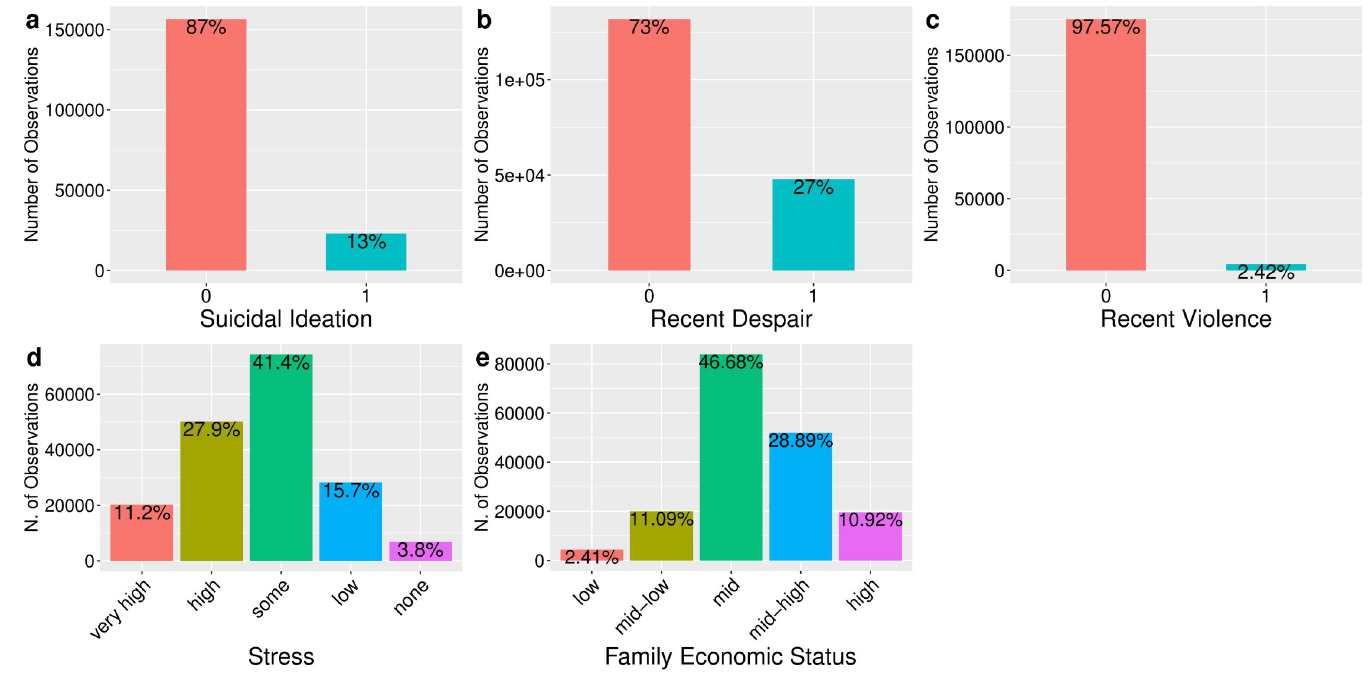
Fig 1. Distribution of key